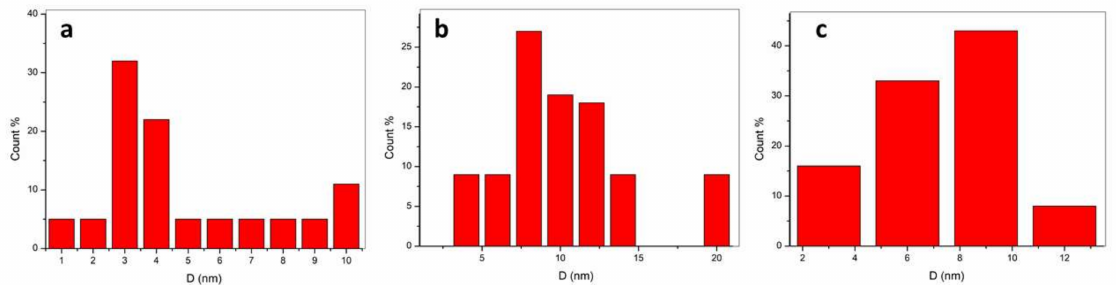
Figure 8. Particle size distribution of Ni/MgAl 2 O 4 sulfided with (NH 4 ) 2 SO 4 (S1) at ( a ) 200 ◦ C, ( b ) 400 ◦ C, and ( c ) 550 ◦